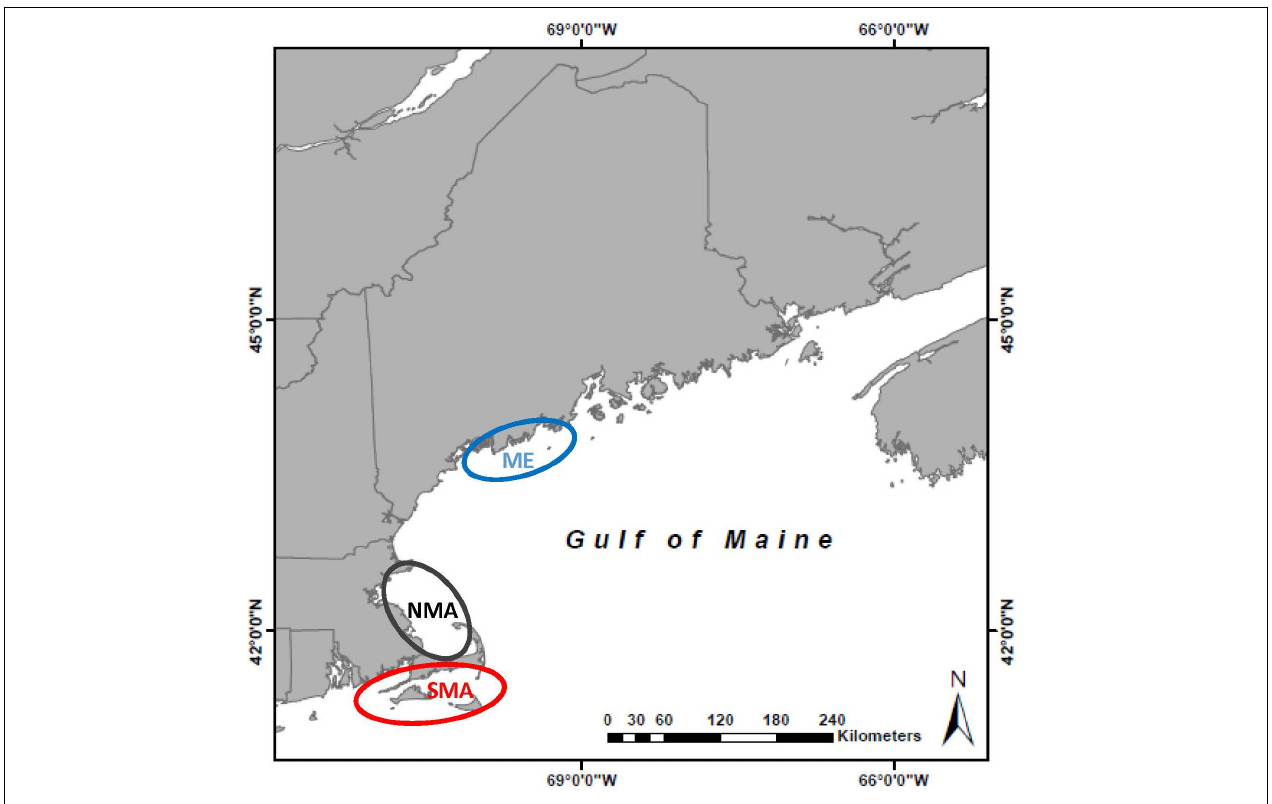
FIGURE 1 | Map of the Gulf of Maine with field sites delineated: Maine (ME) in blue, northern Massachusetts (NMA) in gray, and southern Massachusetts (SMA) in red.